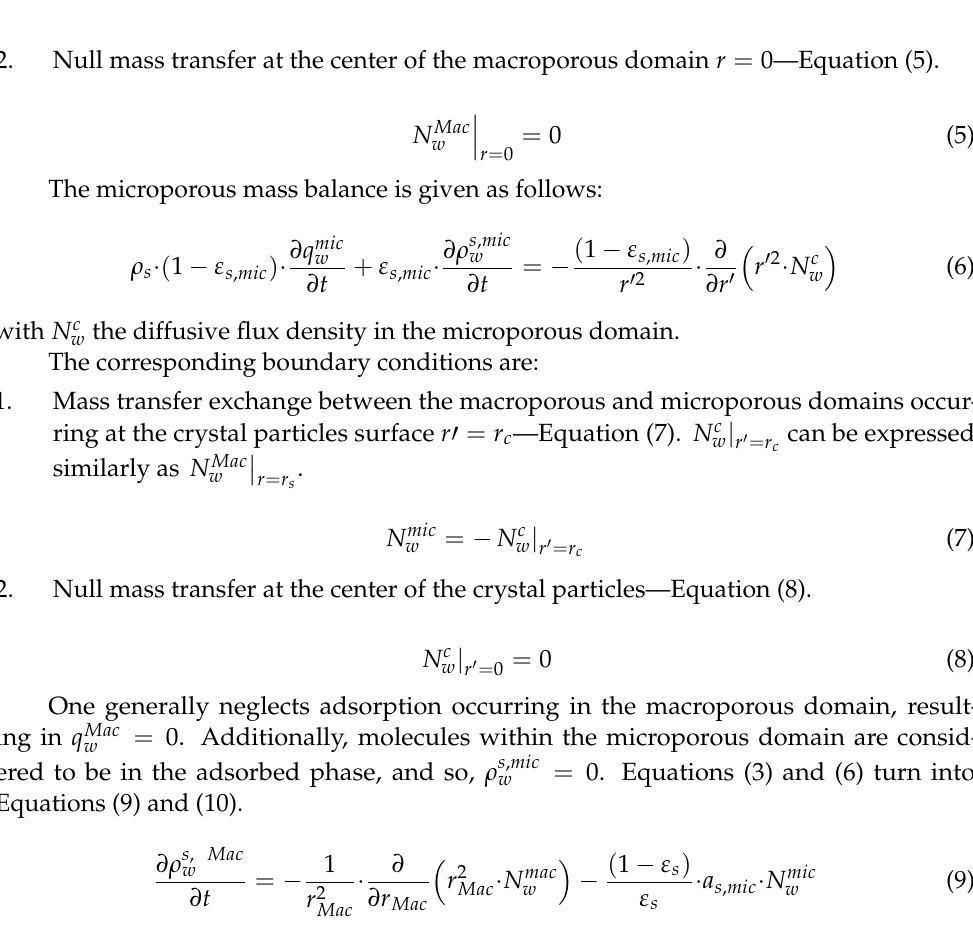
with N c the diffusive flux density in the microporous domain. w